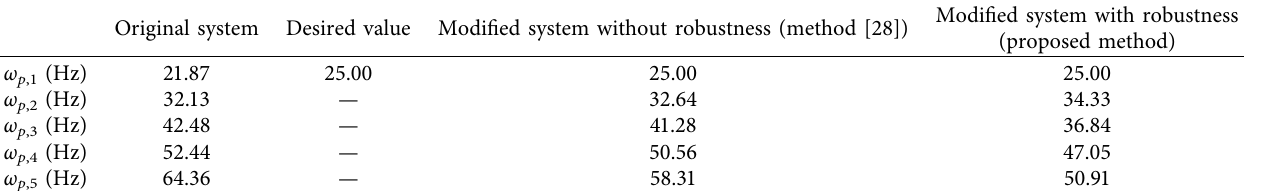
Table 3: Test-case 1: original, desired, and modified system natural